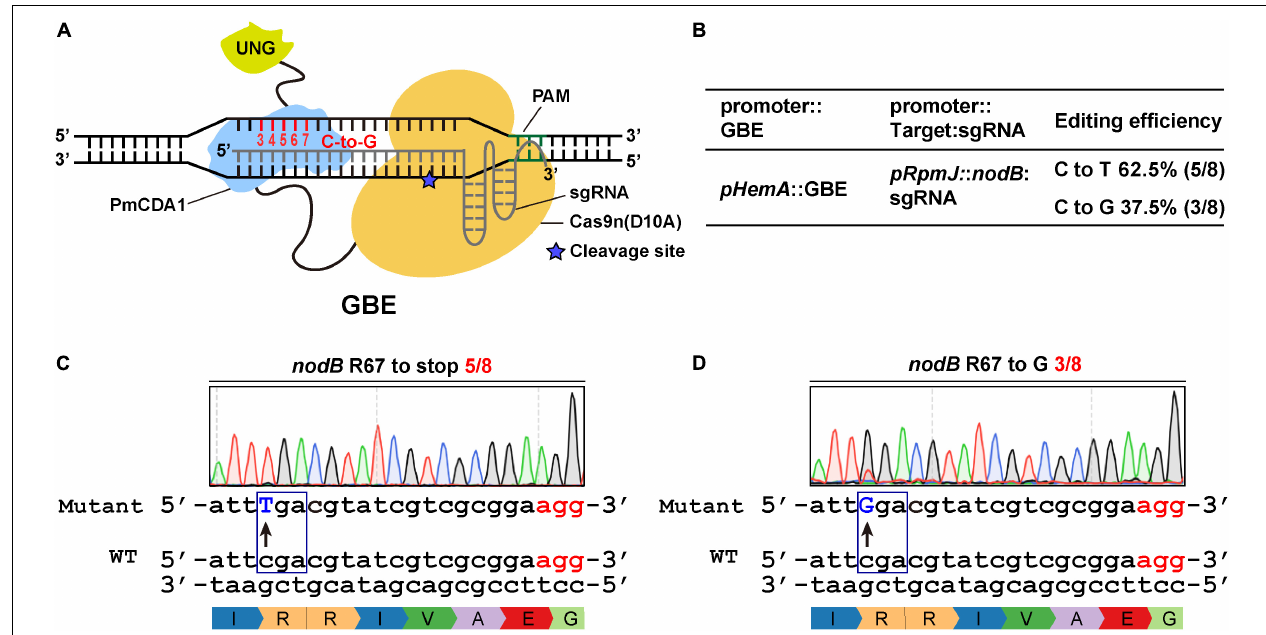
FIGURE 3 | Efficient C-to-G transversions catalyzed by the glycosylase base editor (GBE) system in S. meliloti . (A) Schematic diagram of a glycosylase base editor (GBE). The activation-induced cytidine deaminase (AID) ortholog PmCDA1 was fused to the C-terminus of the Cas9 nickase. UGI was replaced with the uracil DNA N-glycosylase (UNG), which was fused to the C-terminus of PmCDA1. The potential editable sites of the GBE system are highlighted in red. The asterisk indicates the cleavage site of the Cas9n nickase. (B) Editing efficiency of the GBE system. The expression of the GBE fusion protein was driven by the HemA promoter. The expression of the guide RNAs was driven by the RpmJ promoter. (C,D) Conversion of the codon encoding R67 in the nodB gene to either a stop codon (C) or codon encoding glycine (D) . The conversion efficiencies were 5/8 (C) and 3/8 (D)